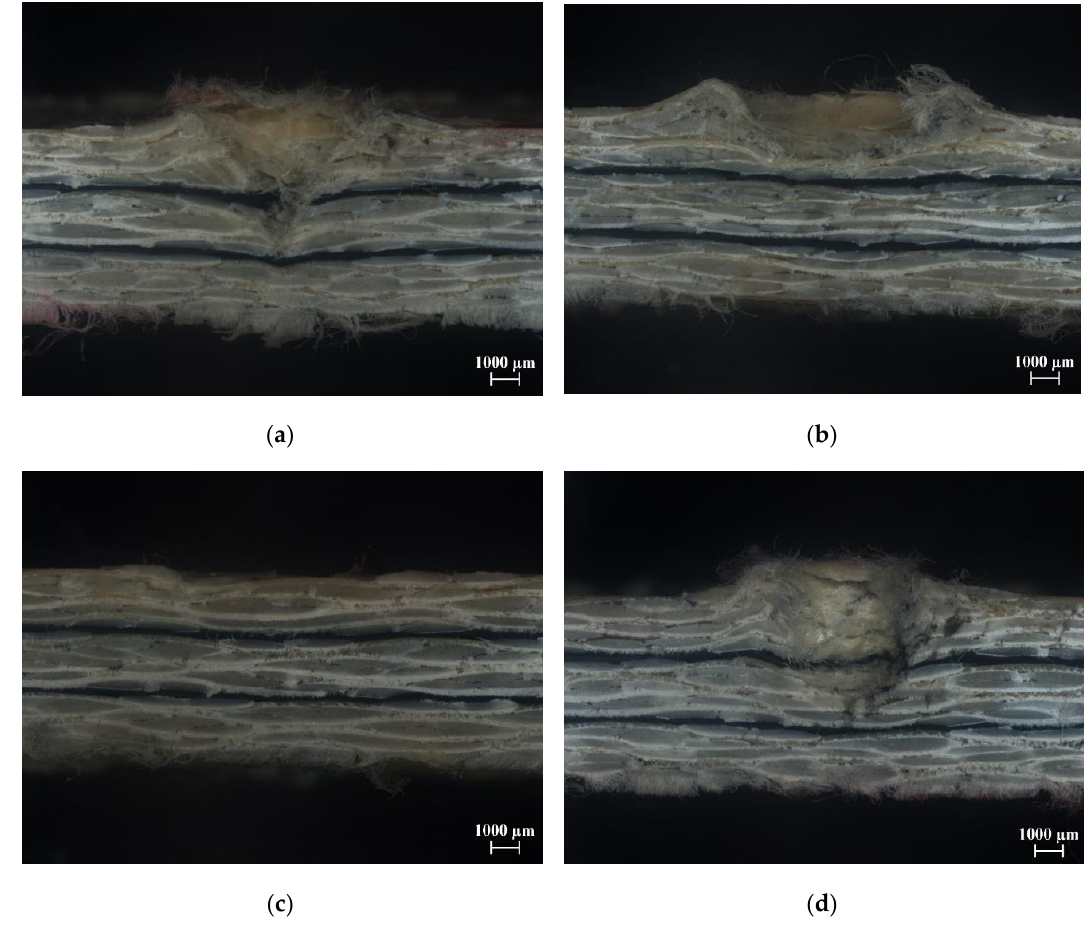
Figure A2. Cross sections of the damage formed in the composite panels after impact of the striker: ( a ) conical, ( b ) hemispherical, ( c ) blunt, ( d ) ogival.